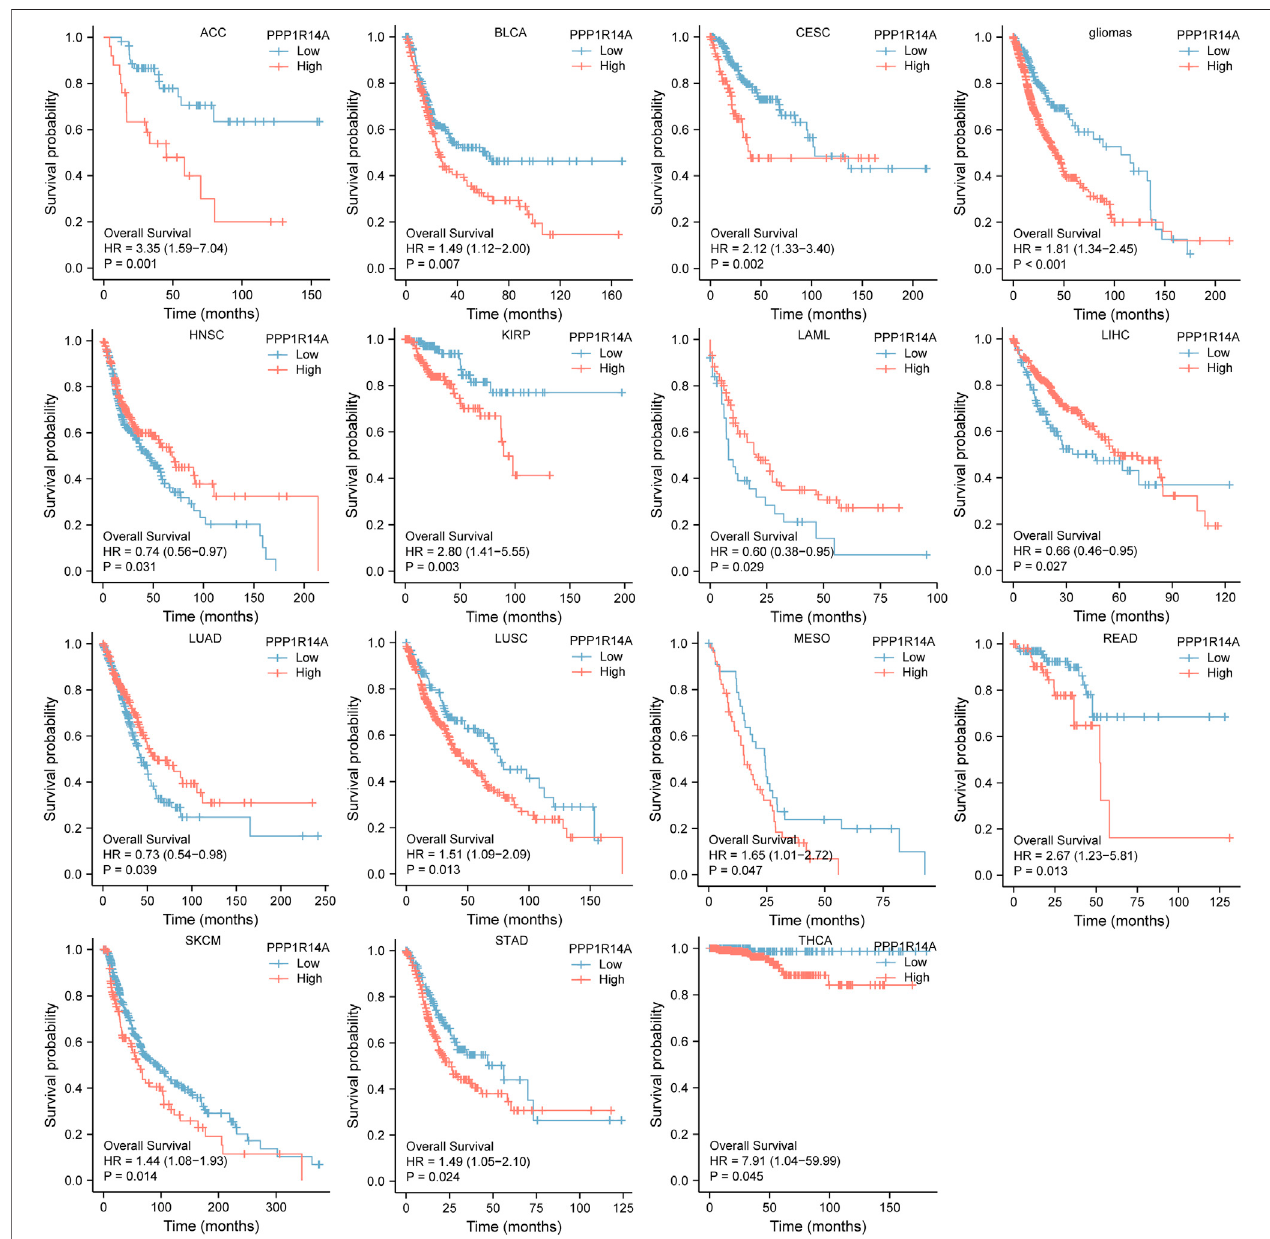
FIGURE 4 | Association between the PPP1R14A expression and the OS of cancer patients. Kaplan – Meier survival curves for patients strati fi ed by the different expressions of PPP1R14A in ACC, BLCA, CESC, gliomas, HNSC, LAML, LIHC, LUAD, LUSC, MESO, READ, SKCM, STAD, and THCA.